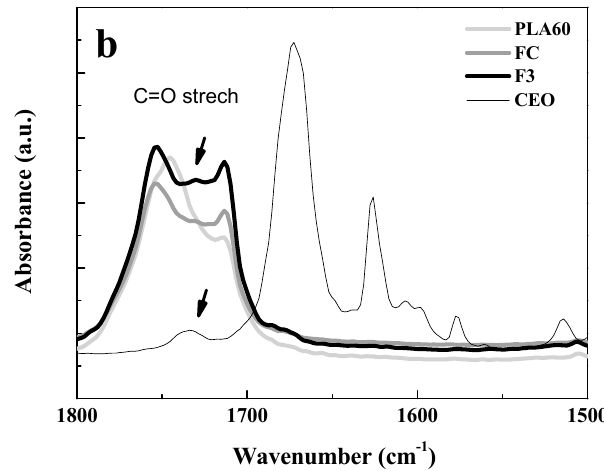
Figure 3. FTIR spectra of: ( a ) CEO, homopolymers (PLA100, PBAT100), blends (PLA50, PLA60, PLA70), and fibers (FC, F3) and ( b ) detail for CEO, PLA60, FC, and F3. To understand the interactions between the CEO and the polymer blends, FTIR measurement was done. The main characteristic absorption bands for CEO, PLA100, and PBAT 100 are shown in Table 4. FTIR characteristic absorption bands for CEO, PLA, and